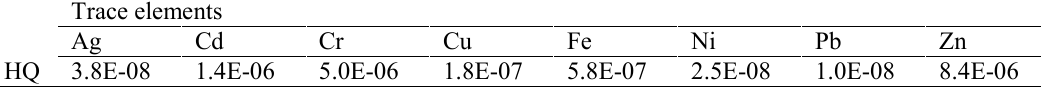
Table 3. Non-carcinogenic risk (HQ) for individual trace elements detected in cosmetic products in Sanandaj City,